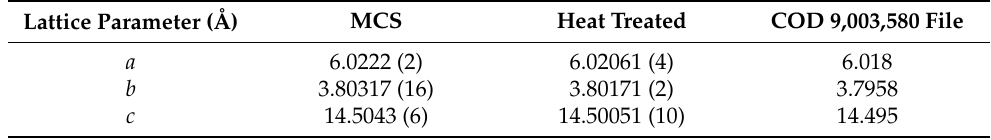
Figure 7. Rietveld refinement of the XRD pattern of mechanochemically synthesized CuSbS 2 powders heat-treated at 350 ◦ C/24 h. Table 1. Results of the Rietveld refinement for the lattice parameters of the mechanochemically synthesized CuSbS 2 powders and of the heat-treated CuSbS 2 powders. For comparison purposes, the standard values from the COD 9,003,580 file are also